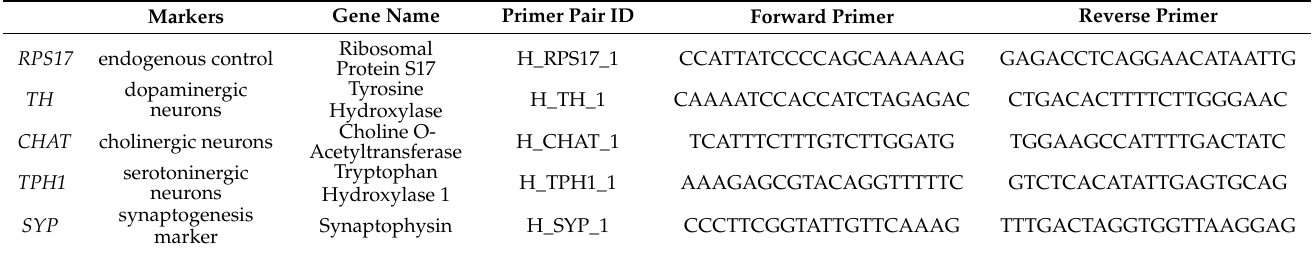
Table 2. Information about the evaluated reference control genes and neuronal marker genes. The primer pair ID was compatible with the KiCqStart Primers (Sigma-Aldrich). Nomenclature according to HUGO Gene Nomenclature